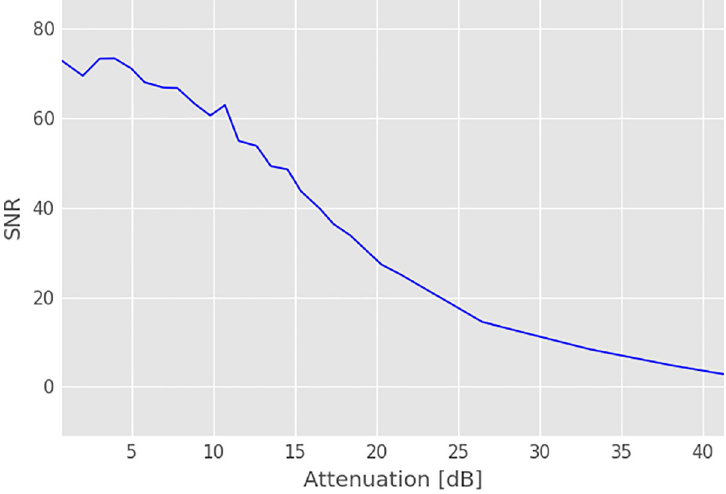
were carried out on a 9.4 T animal scanner [40] by inserting a variable attenuator at the location of the proposed switch matrix. Single slice gradient echo (TE = 10 ms, TR = 100 ms, FA = 15) images were acquired using a linear-polarized birdcage resonator and a 63 ml sample (per 1000 g distilled water 5 g NaCl and 1.25 g NiSo x 6 H O) to measure SNR as a function of attenuation as 4 2 described in [41], Method 2. The results of the measurement are given in Fig 3.